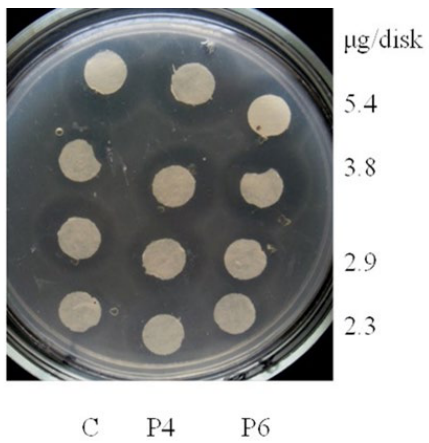
Figure 7. Growth inhibition of Staphylococcus aureus ( S. aureus ). In this and the following figures: C — control (oxytetracycline hydrochloride); P4 and P6—oxytetracycline in complex with polyphosphate ester-type transporters. Table 1. Area of growth inhibition of Staphylococcus aureus ( S. aureus ). Table 1. Area of growth inhibition of Staphylococcus aureus ( S. aureus